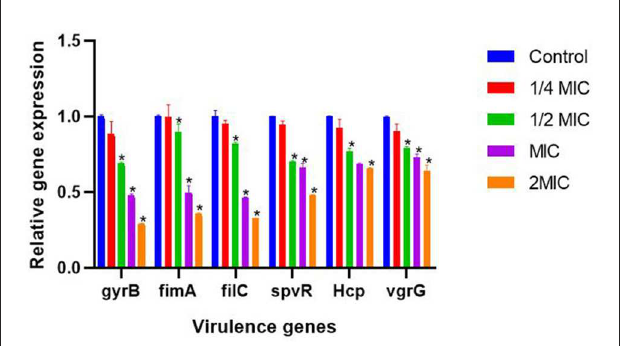
FIGURE9 The effect of 1/4 MIC to 2 MIC SEDQ concentration on the expression of six virulence genes of Salmonella enteritidis . Compared with control group, * showed significant difference at P <